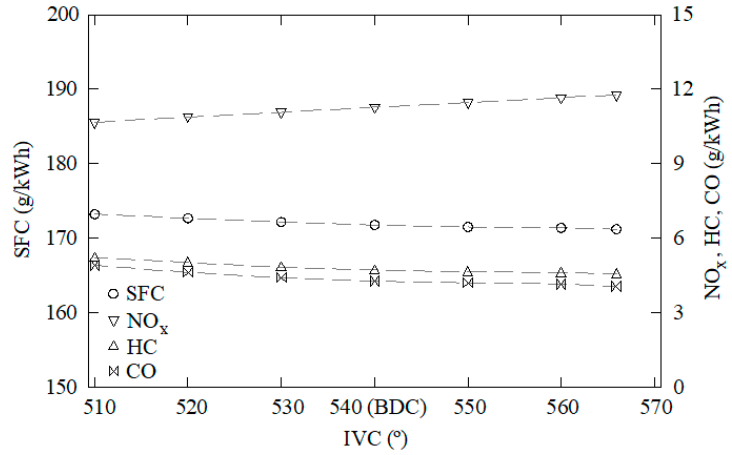
Figure 6. SFC, NO x , CO, and HC emissions against the intake valves closing instant. EGR rate = 0, water to fuel ratio = 0, overlap timing = 96°, cooling water temperature = 76 °C.